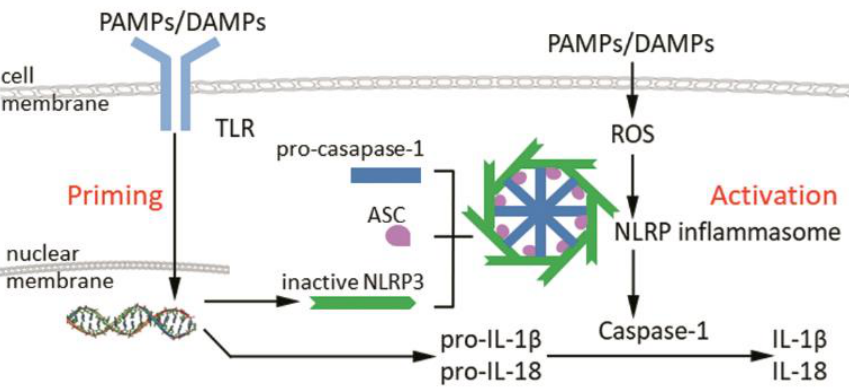
Figure 1. Generation of the canonical inflammasome via two sequential signaling events.